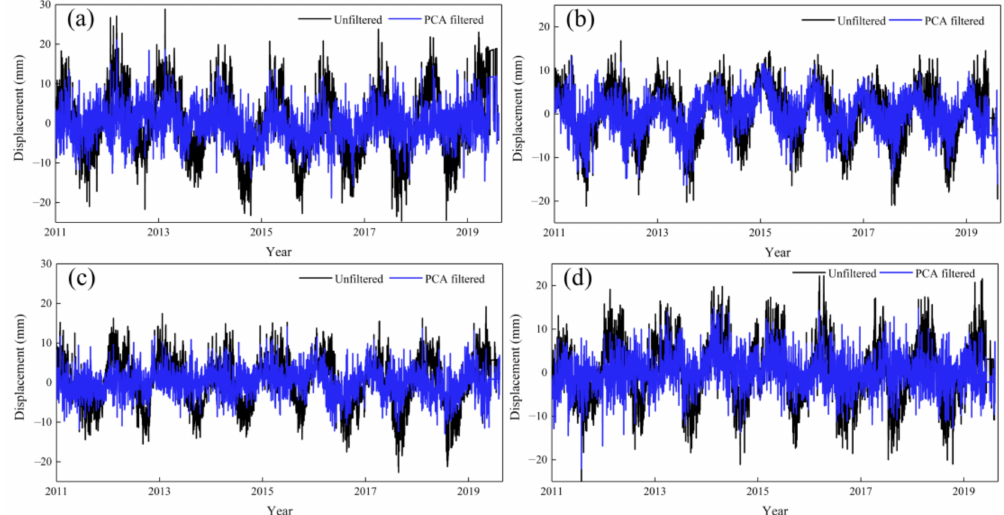
Figure 7. Unfiltered and PCA-filtered GNSS vertical time series for SCML ( a ), SCXC ( b ), YNLJ ( c ), and YNYS ( d ) stations.